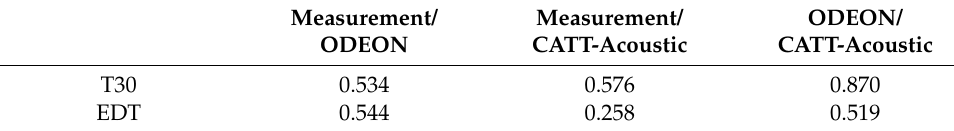
Table 4. Correlations between measurement and simulations for T30 and EDT.